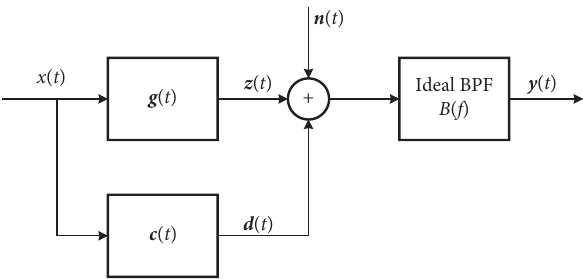
Figure 1: The target channel model in clutter